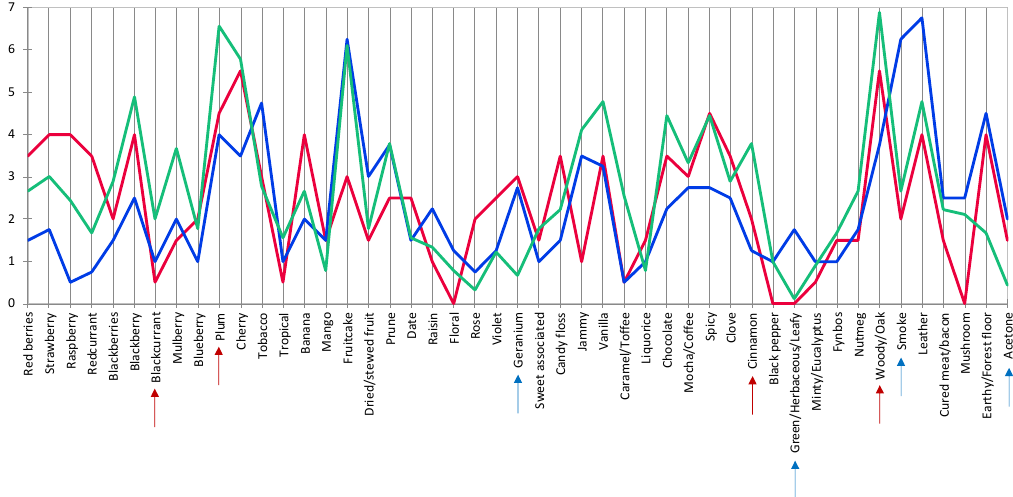
Figure 4. HCA cluster profile plot for Pinotage. The blue and red arrows indicate negative and positive drivers of quality, respectively. The color of the graph lines corresponds to the clusters indicated in Figure 3.